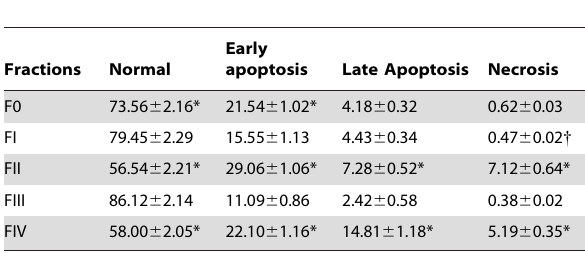
Table 2. The apoptosis of cells from each fraction after paclitaxel treatment